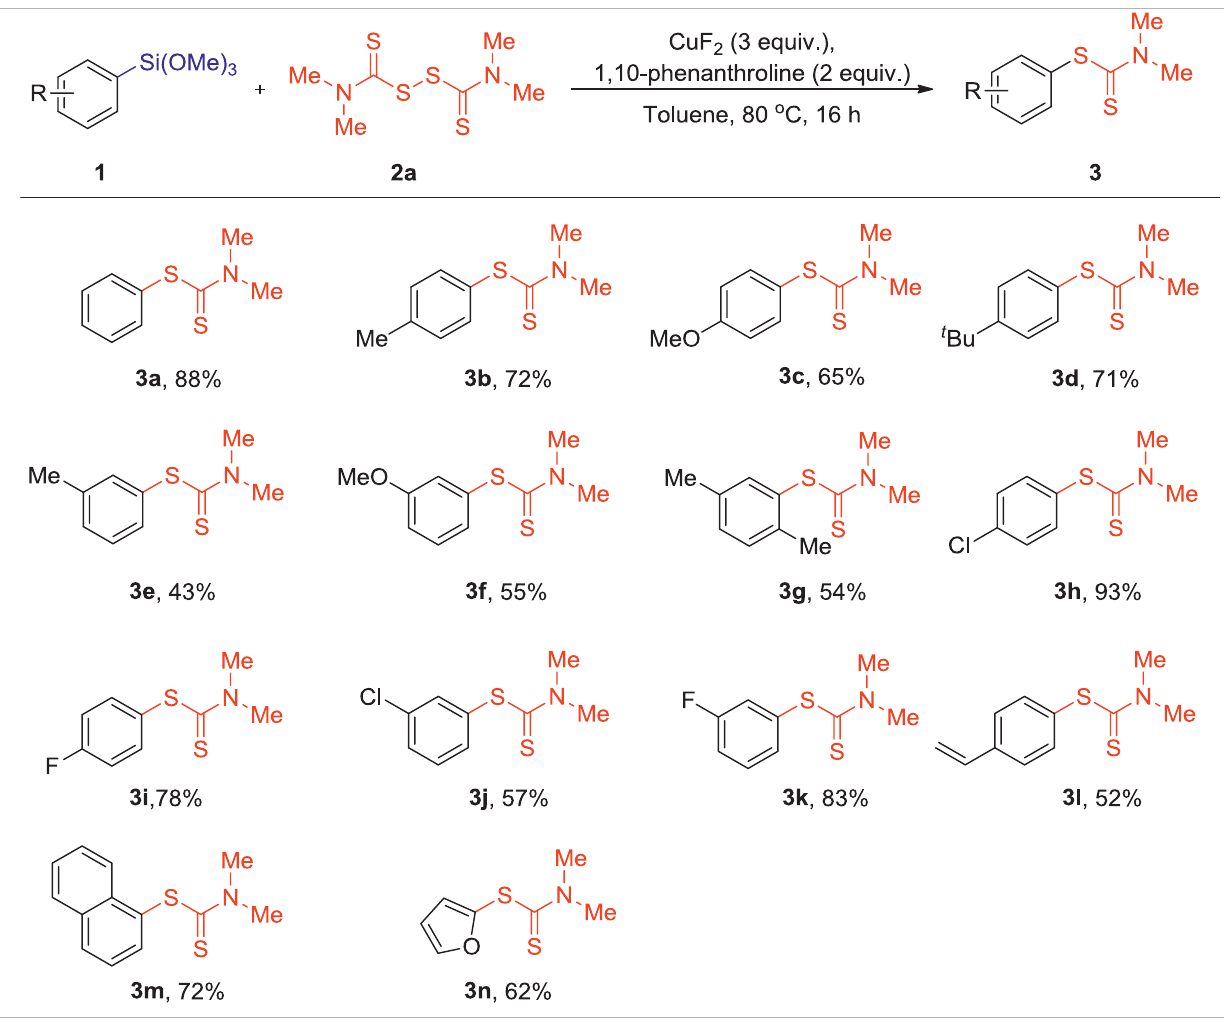
TABLE 2 | Reactions of arylsilanes 1) with tetramethylthiuram disul fi de (2a) a,b